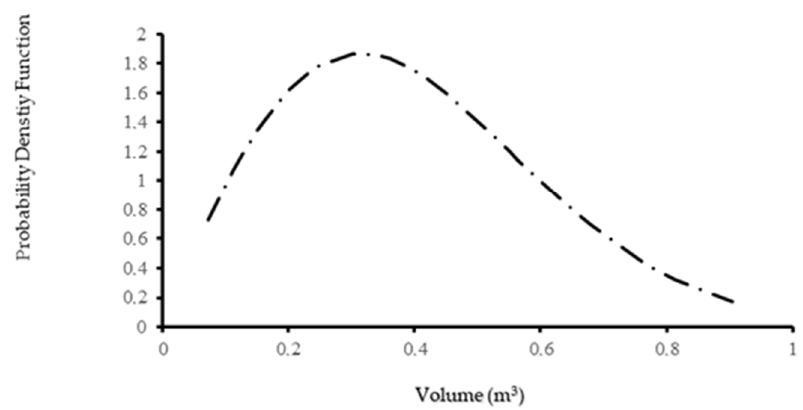
Figure 4. Weibull distribution based on obtained volume data.